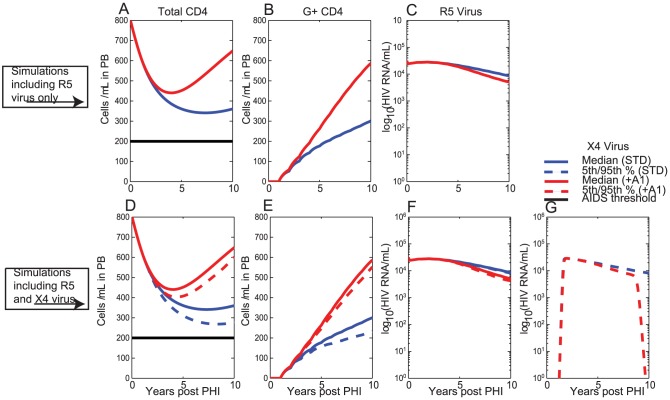
Repeated annual delivery of gene therapy to CD34+ HSC assuming that 20% of CD34+ HSC in the bone marrow receive the gene construct every year from year 1 (i.e. every year, starting from year 1, 20% of G- CD34+ HSC become G+ CD34+ HSC).The legend for this figure is the same as for Figure 5.